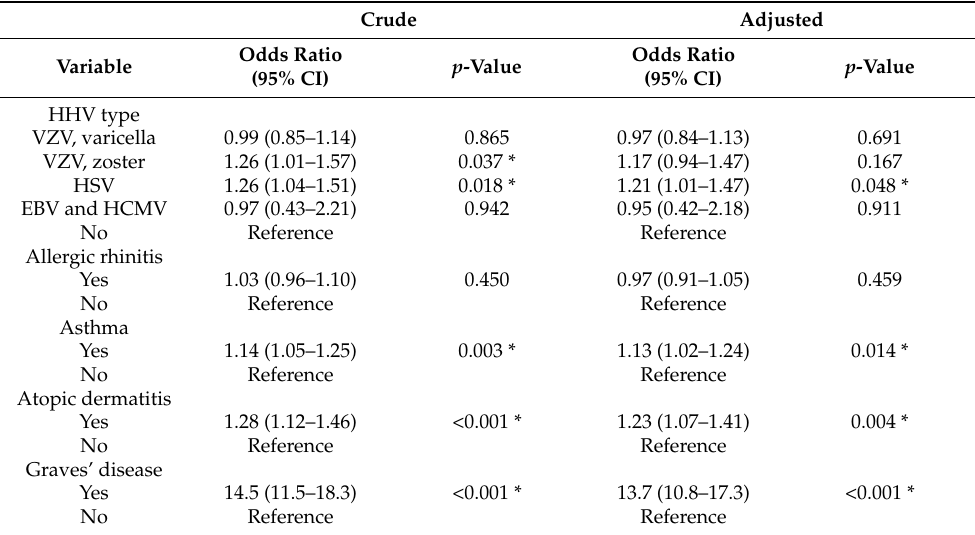
Table 2. Estimating risk of T1DM by multivariable conditional logistic